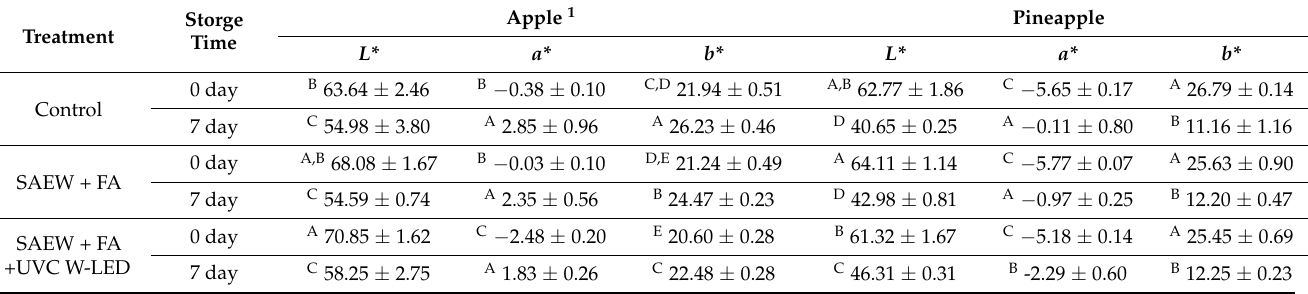
Table 3. Effectiveness of disinfection treatments on color parameters in apple and pineapple after storage for 7 days at 15 ◦